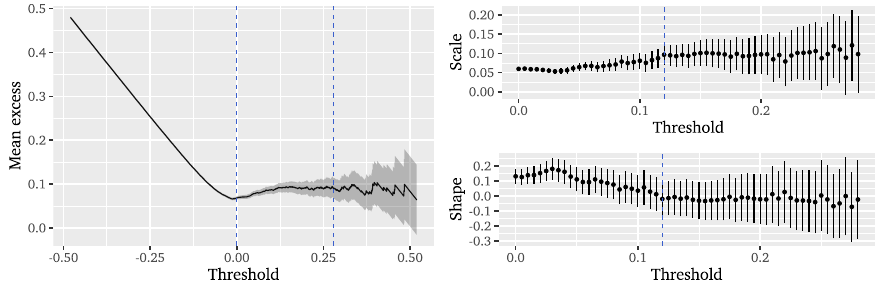
Figure 10. Mean residual life plot and GPD parameter stability plots for the ARFIMA ( 4,0.1398,4 )